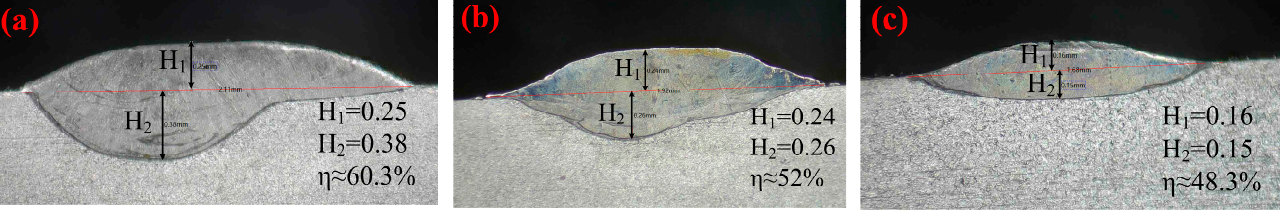
Figure 3. Cross-sectional morphology of the three coatings: ( a ) FeCoNiCrMo0.2 coating; ( b ) FeCoNiCrMo0.2 + 32%WC coating; ( c ) FeCoNiCrMo0.2 + 32%WC + 2%CeO 2 coating.